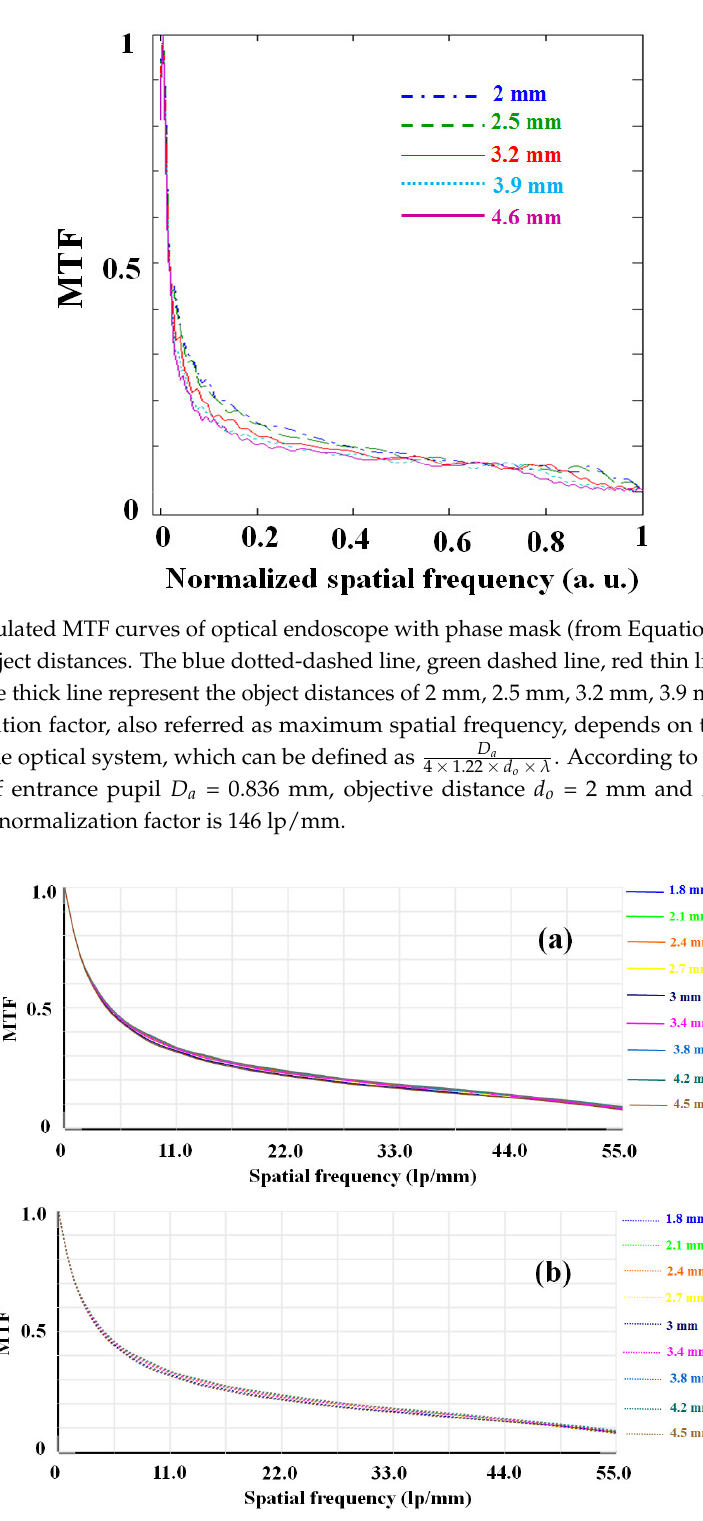
Figure 8. Simulated MTF curves of optical endoscope with phase mask, varied with object distances. ( a ) Tangential direction. ( b ) Sagittal direction. The blue line, green line, orange line, yellow line, mazarine line, purple line, cyan line, aquamarine line and gray line represent the object distances of 1.8 mm, 2.1 mm, 2.4 mm, 2.7 mm, 3 mm, 3.4 mm, 3.8 mm, 4.2 mm and 4.5 mm,